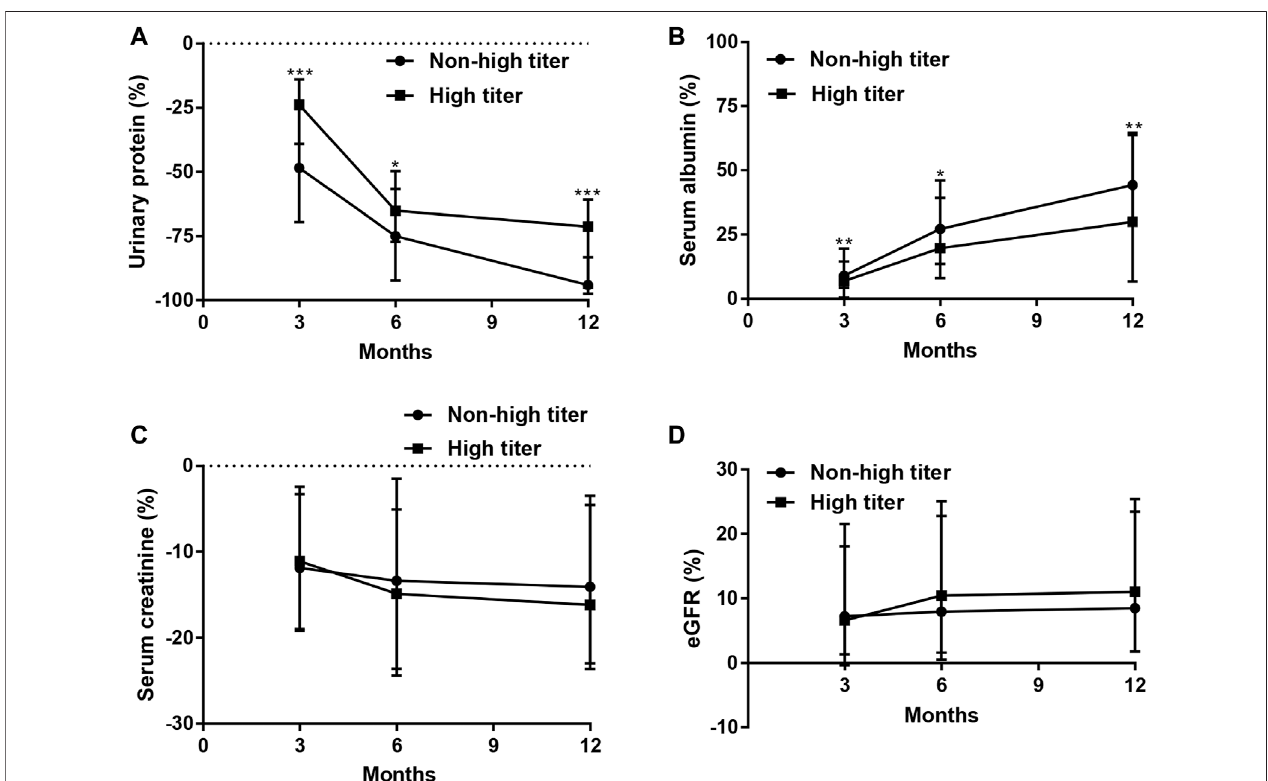
FIGURE 6 | Percentage changes in urinary protein, serum albumin, serum creatinine, and eGFR over time. Compared to baseline, at 3, 6, and 12 months, the decrease ofurinaryprotein (A) ( p < 0.001, p (cid:1) 0.016, p < 0.001,respectively)andtheincrease ofserum albumin (B) ( p (cid:1) 0.002,0.016,0.001,respectively) more rapidin non-hightitergroup thaninhightiter group, whilethere werenosigni fi cantdifferences inthedecrease inserum creatinine (C) ( p (cid:1) 0.825,0.499,0.440,respectively)and in the increase in eGFR (D) ( p (cid:1) 0.971, 0.291, 0.460, respectively) at 3, 6, and 12 months between the two titer groups. eGFR: estimated glomerular fi ltration rate. * p < 0.05, ** p < 0.01, *** p <